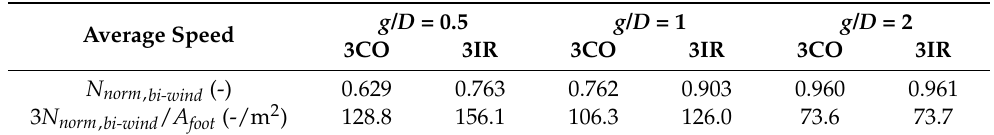
Table 4. Comparison of normalized rotational speed N norm , bi-wind and 3 N norm , bi - wind / A foot in a trio of VAWT models in an isotropic bidirectional wind